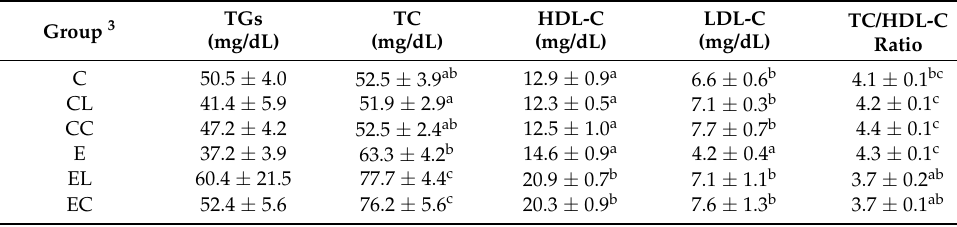
Table 6. Effects of different dietary fat sources on blood lipid profiles in rats 1,2 .